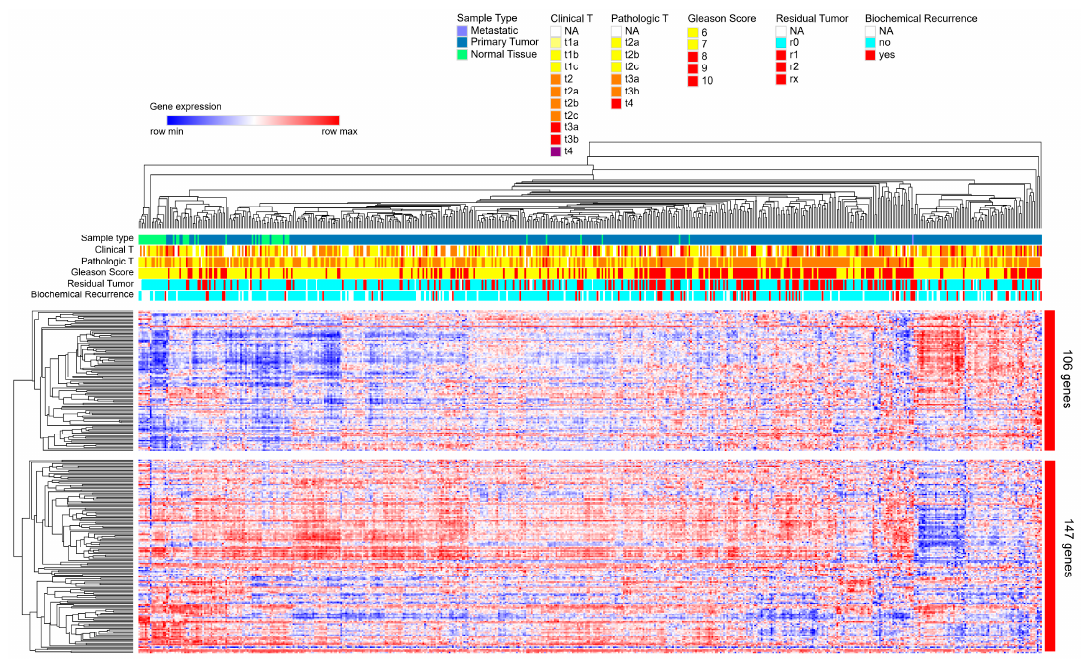
Figure 5. Hierarchical clustering based on the expression of 253-snc886-3p direct candidate target genes in prostate tissue of PRAD-TCGA. Heatmap of the expression of the 253 genes obtained by a two-way hierarchical clustering using the Spearman rank correlation algorithm with the Morpheus software and PRAD-TCGA data. The principal two gene clusters formed are shown (cluster of 106 genes and cluster of 147 genes). Color scale indicates the relative expression level of the genes across the samples (red and blue represent higher and lower expression relative to the mean). Clinical status for different parameters (Clinical T value, Pathological T value, Gleason Score, Residual Tumor and Biochemical Recurrence) are represented by horizonal marks on the top of the heatmap. The values for each parameter are indicated by colors in the top right legends.